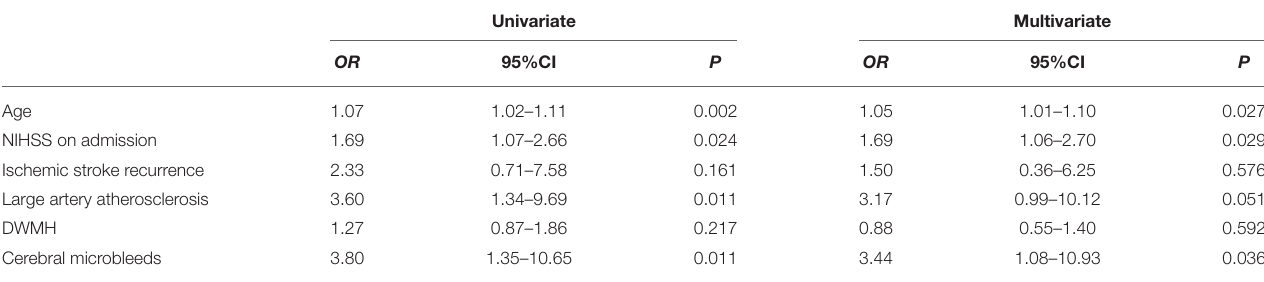
TABLE 5 | Univariate and multivariate logistic regression analyses for poor